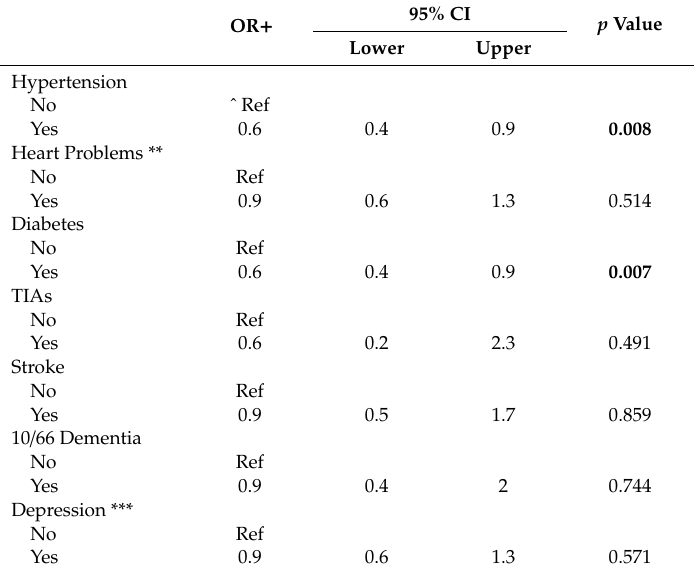
Table 3. Clinical conditions correlates to OSTA ≤ 1 (at risk of osteoporosis). OR